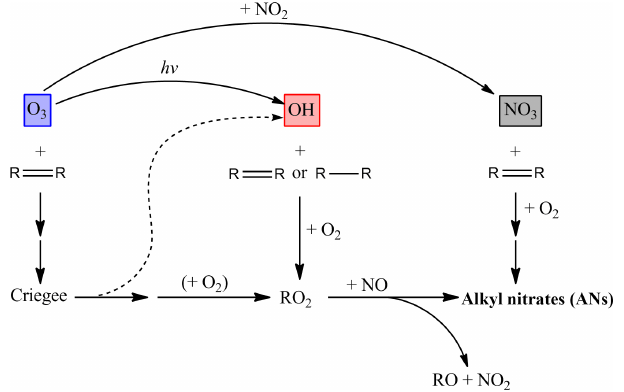
Figure 1. Schematic diagram illustrating the formation of ANs via VOC degradation initiated by NO 3 , OH and O 3